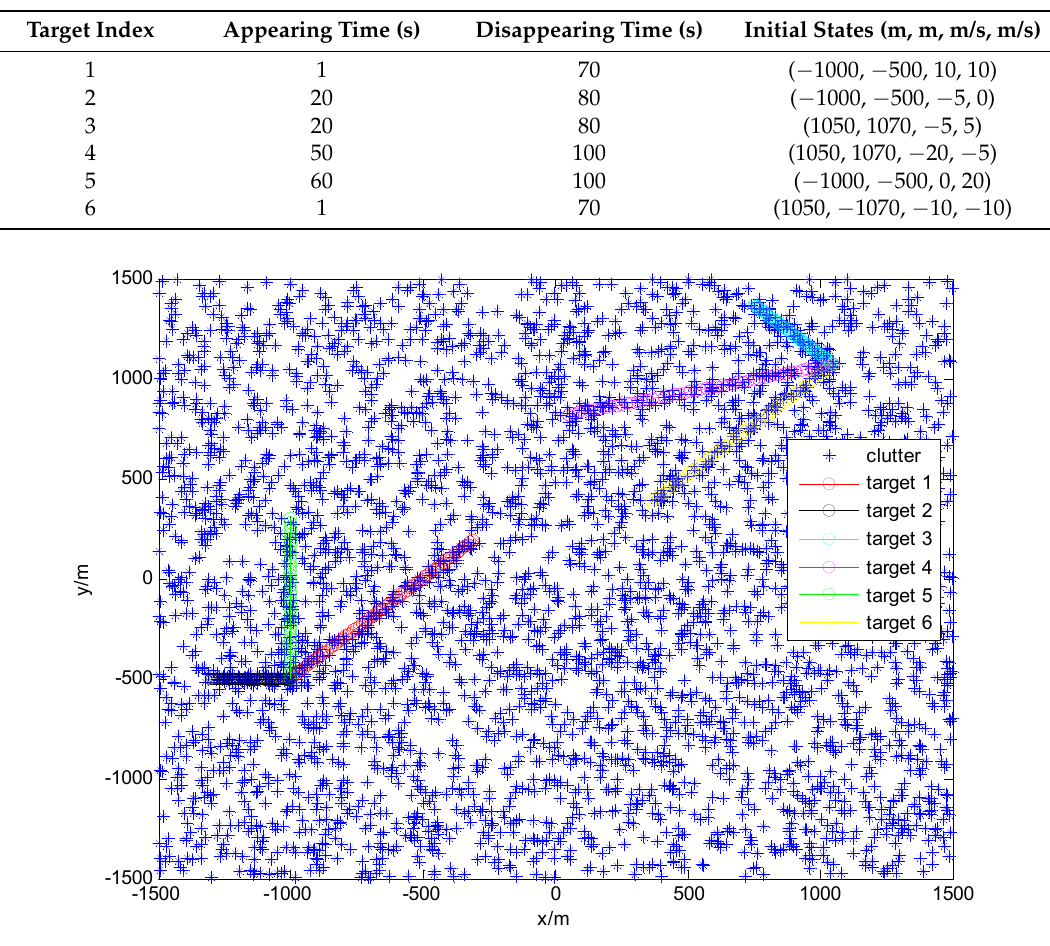
Figure 2. Trajectories of the true targets and the clutters.